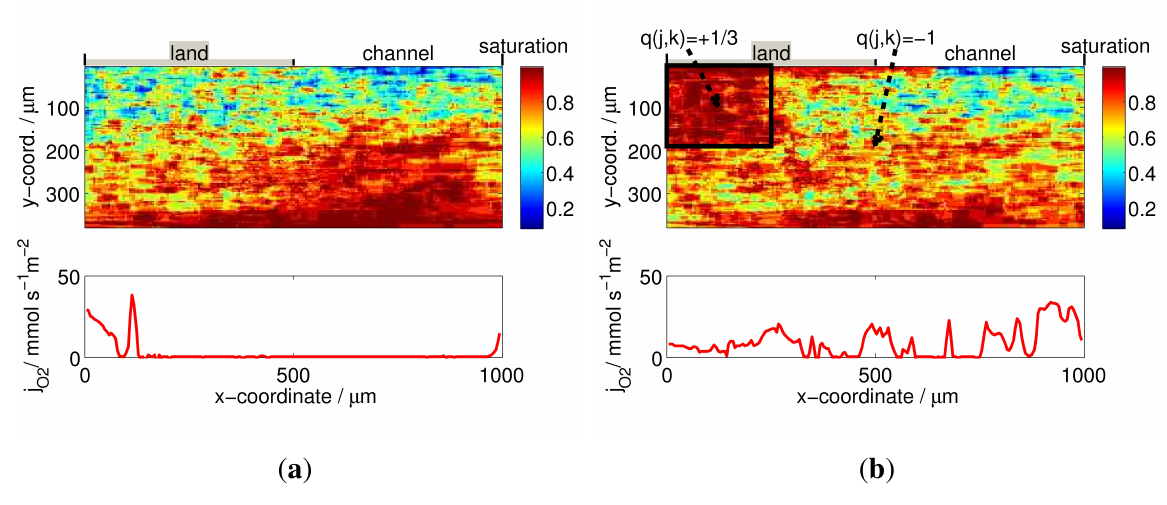
Figure 11. Mean saturation distribution at breakthrough and oxygen flux in the interface towards the electrode [injection (bottom) interface], j condensation under the